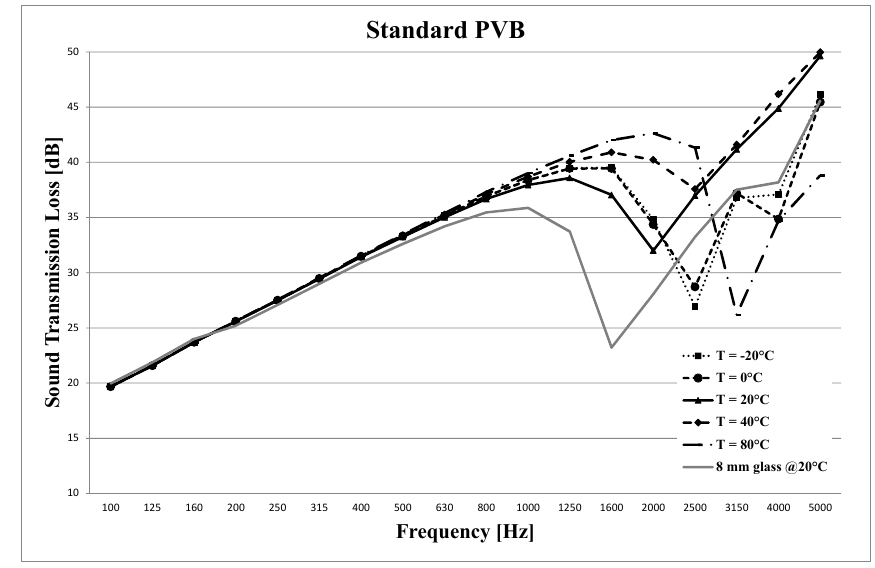
Fig. 13 Sound Transmission Loss Curves of glasses laminated with standard PVB at different